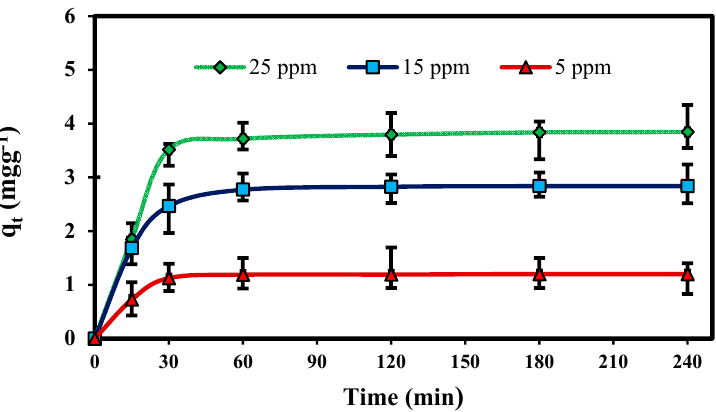
Figure 4. Effect of contact time on the adsorption of Pb(II) onto ZnO-Nano-A at different concentration: (adsorbent mass, 0.1 g L − 1 ; initial pH, 5.0; solution volume, 25 mL; temperature, 30 °C).